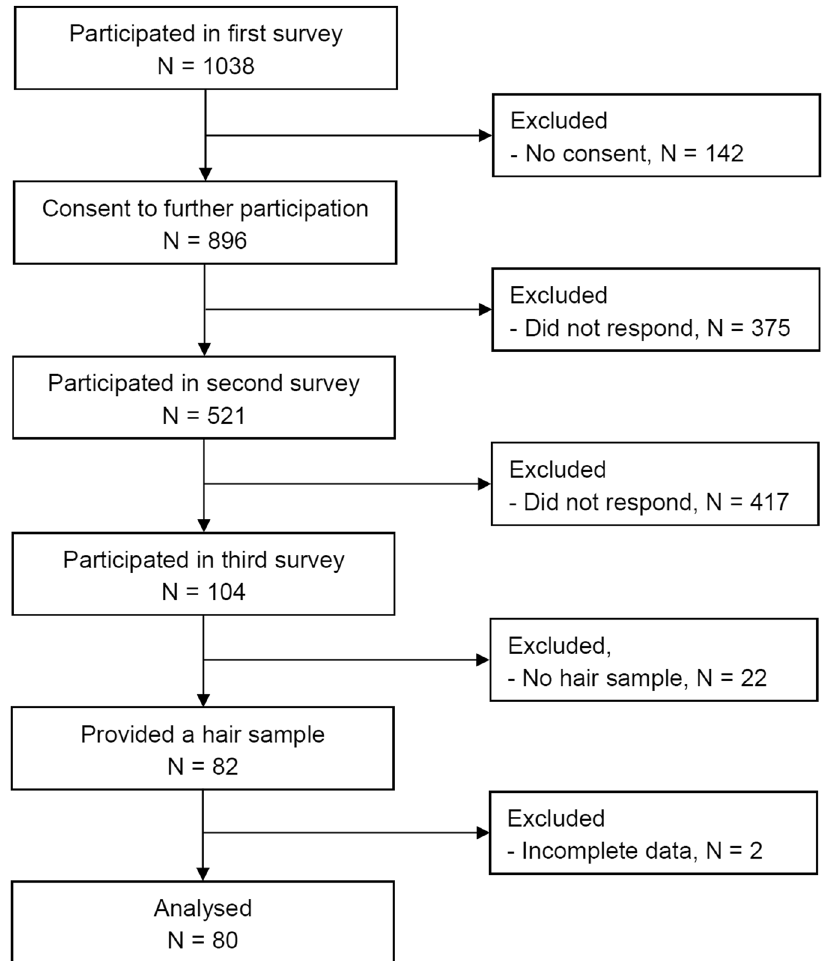
Fig. 2 Flow chart of study inclusion. At T0, 1038 volunteers participated, of whom 521 were reassessed at T1 (50.2%), and 104 were assessed at T2 (10% of the initial sample size). N = 82 participants provided a hair sample. Because of missing questionnaire data, N = 80 participants were included in the fi nal analysis; 72 (90%) were female; mean age was 35.65